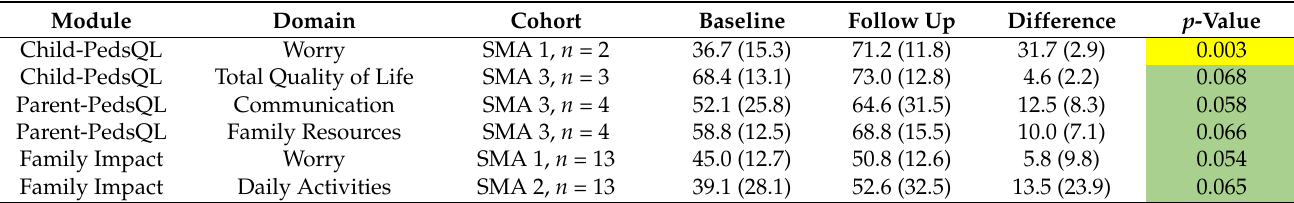
Table 4. Significant Difference in Quality of Life Scales by Cohort.